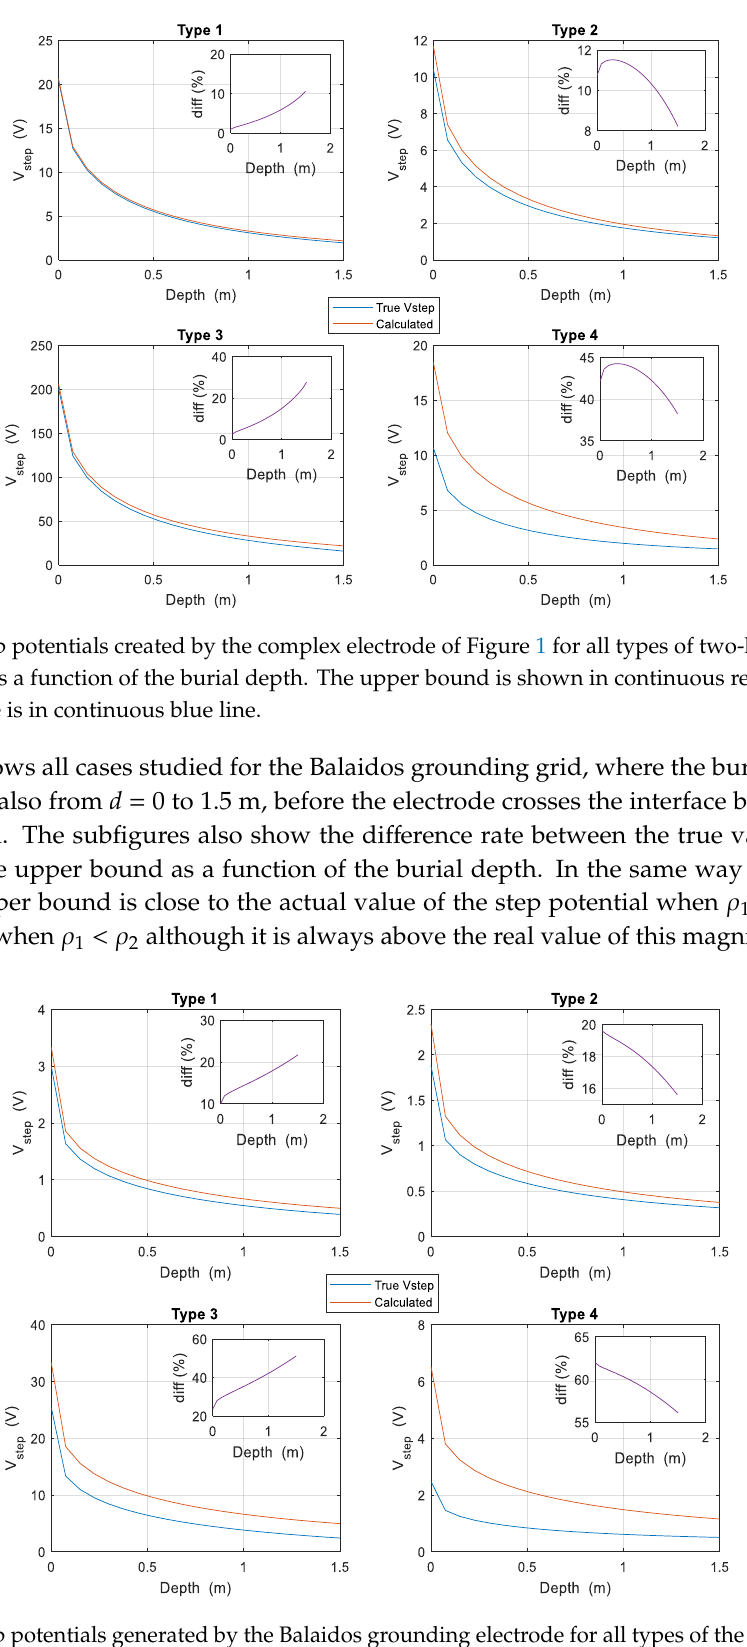
Figure 5. Step potentials generated by the Balaidos grounding electrode for all types of the two-layered soils considered, as a function of the burial depth. The upper bound is shown in continuous red line while the real value is in continuous blue